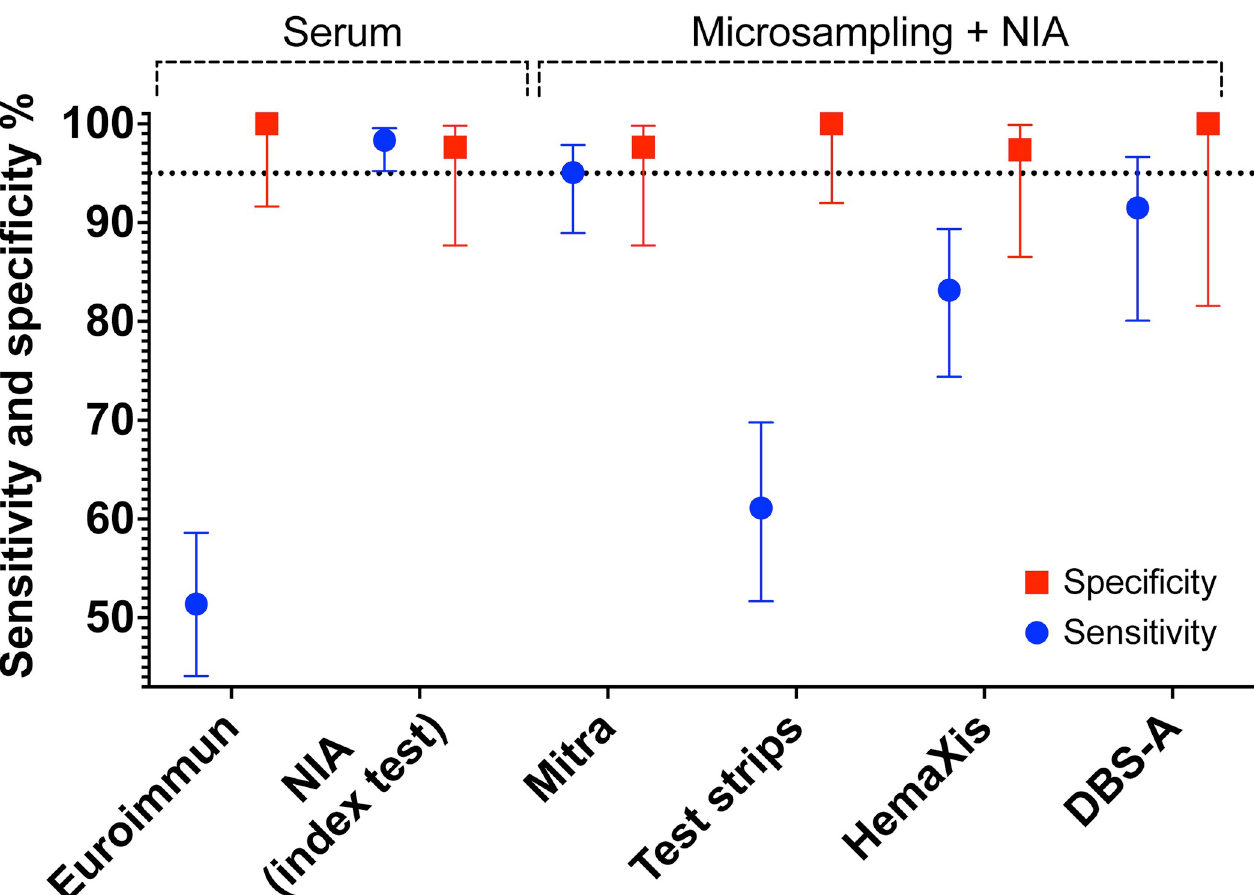
Fig 5. Sensitivity and specificity comparison. Sensitivity and specificity with 95% confidence interval are shown. Euroimmun ELISA and NIA index test were performed on serum obtained by venipuncture. Mitra, (glucose) test strips, and HemaXis correspond to the device used for capillary blood collection after fingerprick, and DBS-A to automated extraction of samples obtained on HemaXis. Capillary blood samples were dried, shipped, and extracted before testing on the NIA assay. A dotted line at 95% sensitivity or specificity is shown for visual aid.